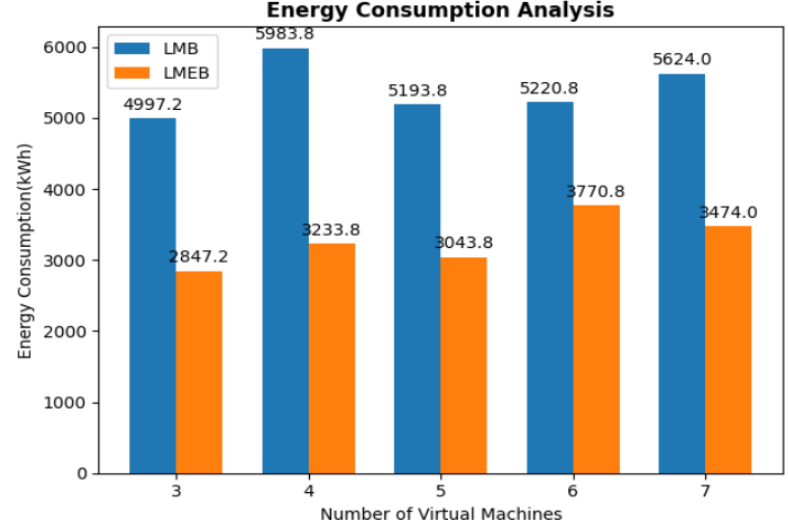
Figure 6. Energy consumption analysis. The migration time analysis is shown in Table 9 and Figure 7.